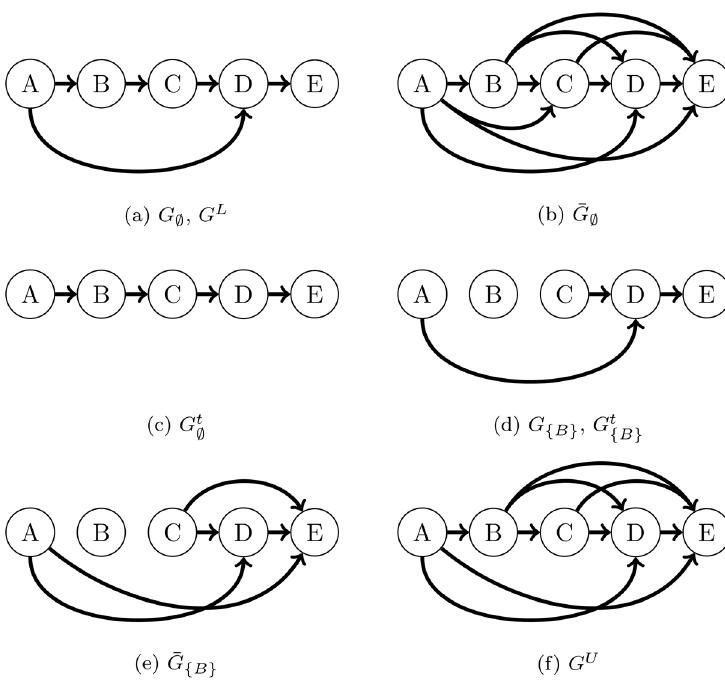
since G 6 0 is a DAG). (c) The transitive 6 0 happens f B g and G t 6 0 f B g